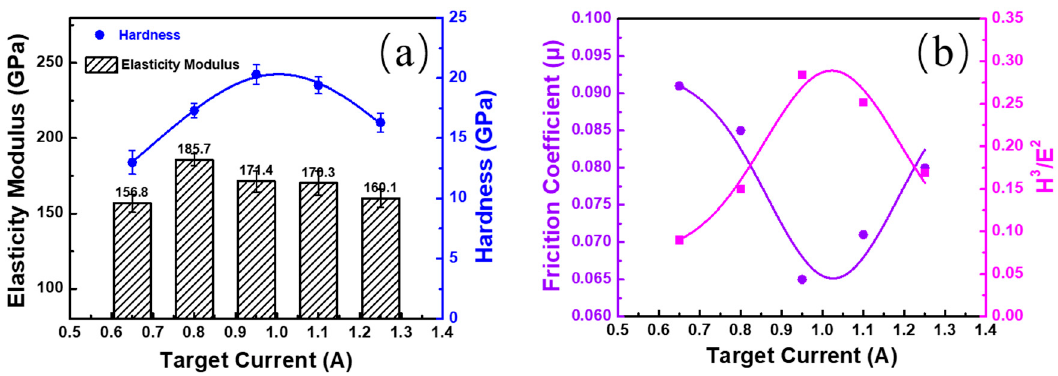
Figure 1. ( a ) The variation of hardness ( H ) and elastic modulus ( E ) for TiC x O y films deposited at different target current, ( b ) the change of friction coefficients and H 3 / E 2 for the TiC x O y films deposited at different target current.